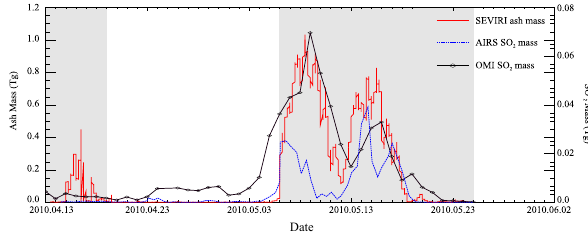
MSG SEVIRI instrument along with the total SO 2 mass detected by the OMI and AIRS instruments for the entire eruption period. The shaded regions define the three different stages of the eruptive